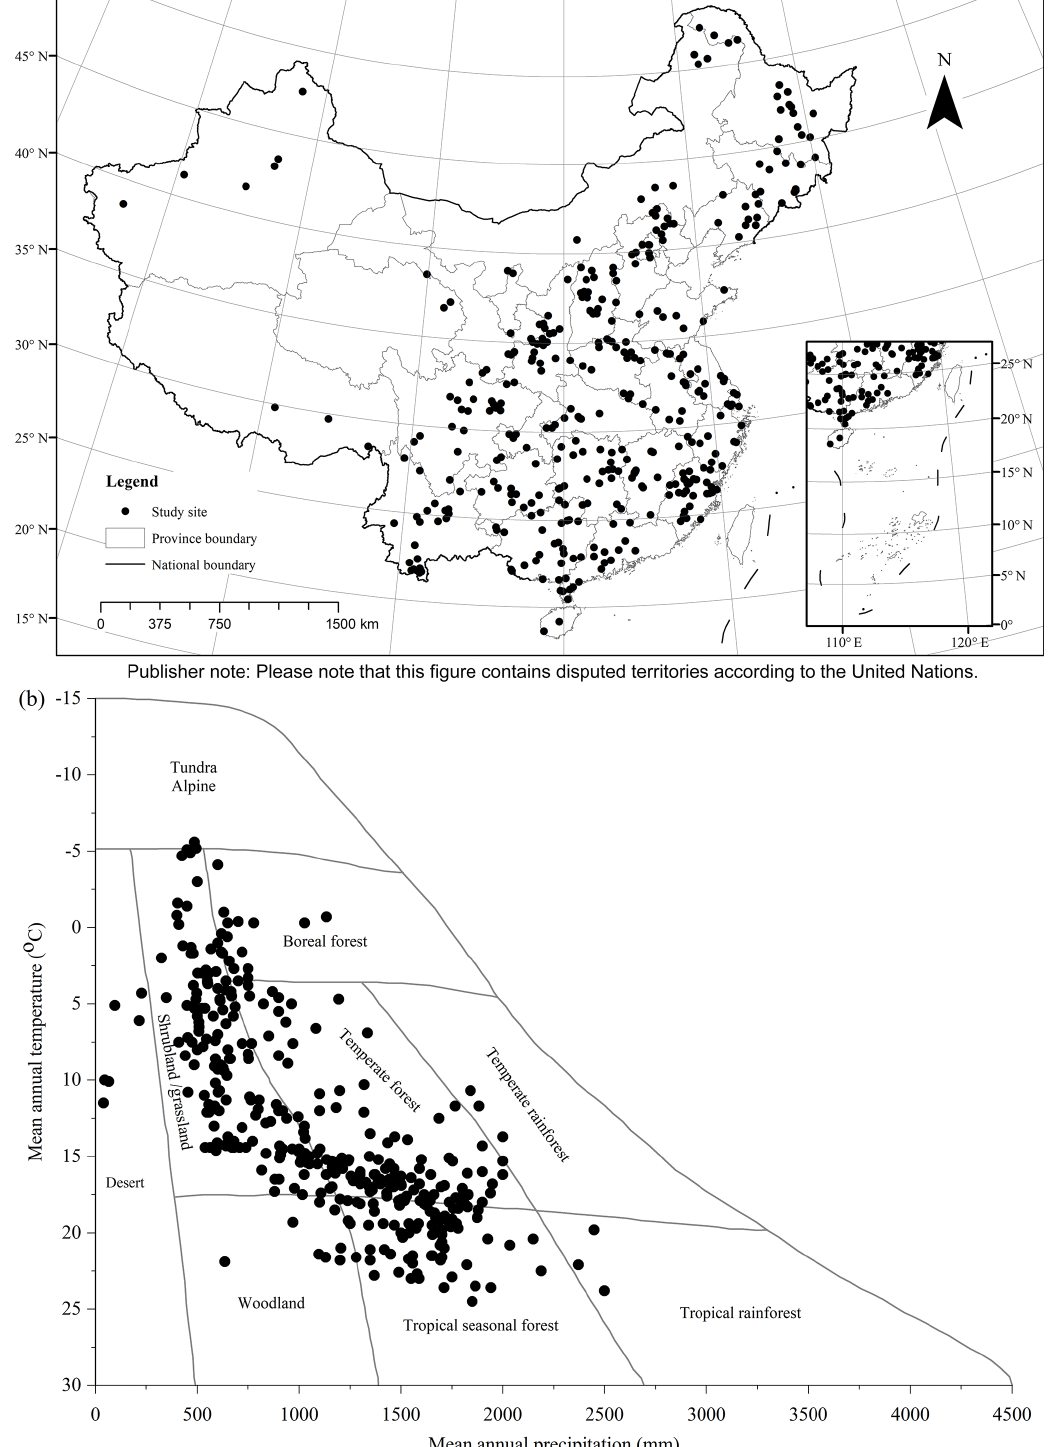
Figure 2. Spatial distribution of study sites: (a) geographical coverage and (b) climate space. Mean annual temperature and precipitation of sites are superimposed upon Whittaker’s climate biome diagram (Whittaker,